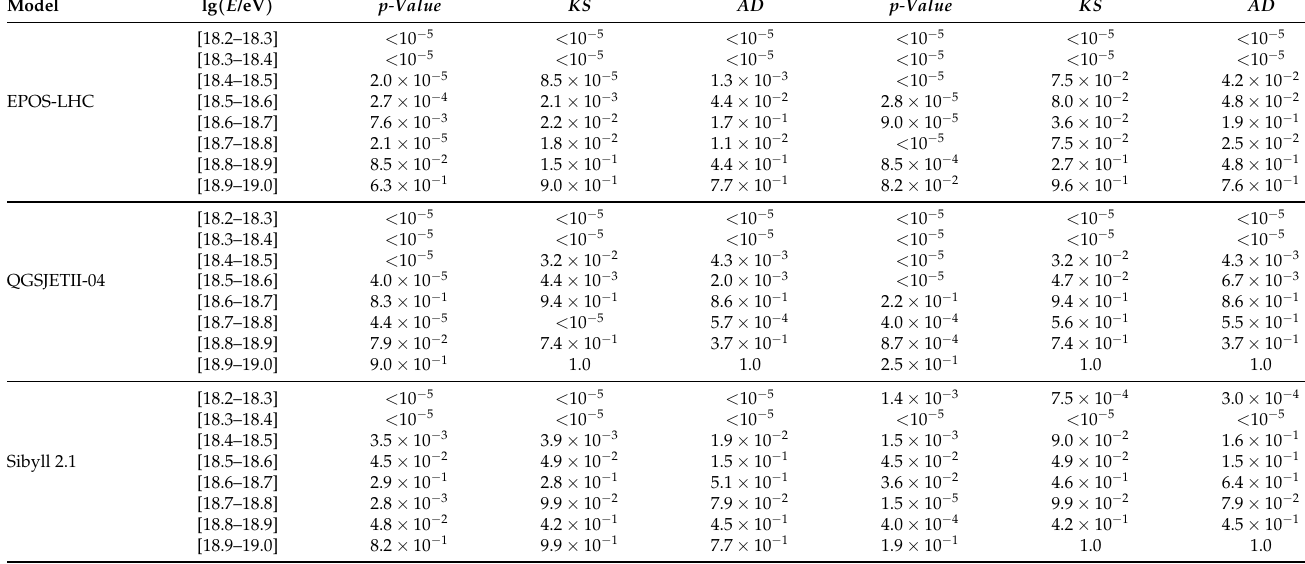
Table 3. The probabilities computed for the three statistical tests of the comparison TA data vs. X Auger Auger fractions obtained using method #1 (left) and #2 (right)